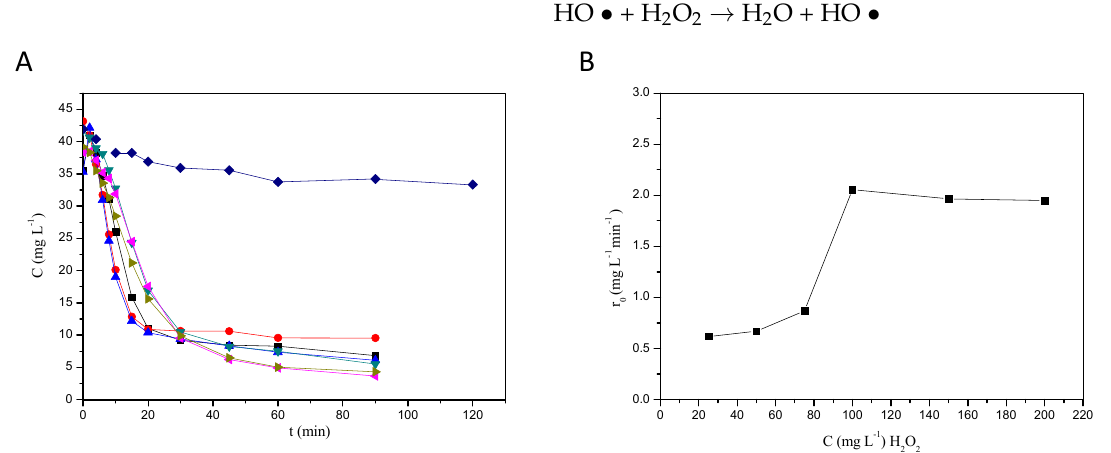
Figure 1. ( A ) Photocatalytic degradation of 40 mg L − 1 CLPR with photo-Fenton reagent in the presence of 7 mg L − 1 Fe 3+ and different H 2 O 2 concentrations. [ (cid:4) ] 200 mg L − 1 H 2 O 2 : ( • ) 150 mg L − 1 H 2 O 2 , ( (cid:78) ) 100 mg L − 1 H 2 O 2 , ( (cid:72) ) 75 mg L − 1 H 2 O 2 , ( ) 50 mg L − 1 H 2 O 2 , ( ) 25 mg L − 1 H 2 O 2 , ( (cid:7) ) (cid:16) (cid:17) 0 mg L − 1 H 2 O 2 . ( B ) Change in the initial degradation rate of CLPR with photo-Fenton reagent in the presence of 7 mg L − 1 Fe 3+ and different H 2 O 2